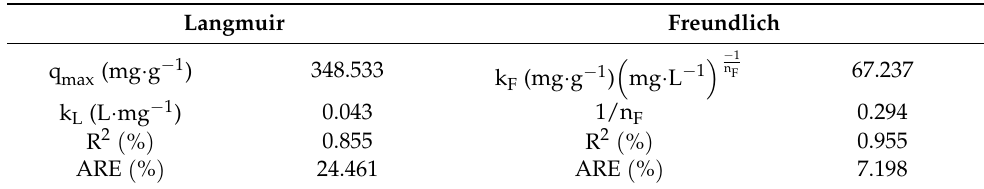
Table 5. Equilibrium isotherm parameters for the Nimesulide adsorption onto ACOP.